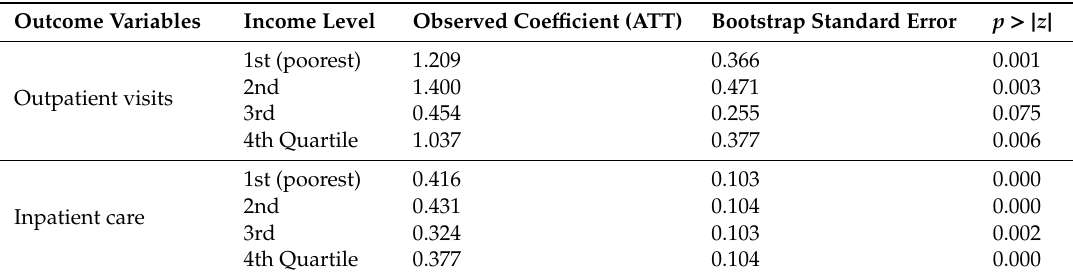
Table 4. Propensity score matching results on average treatment e ff ect (ATT) in TB health care utilization by income